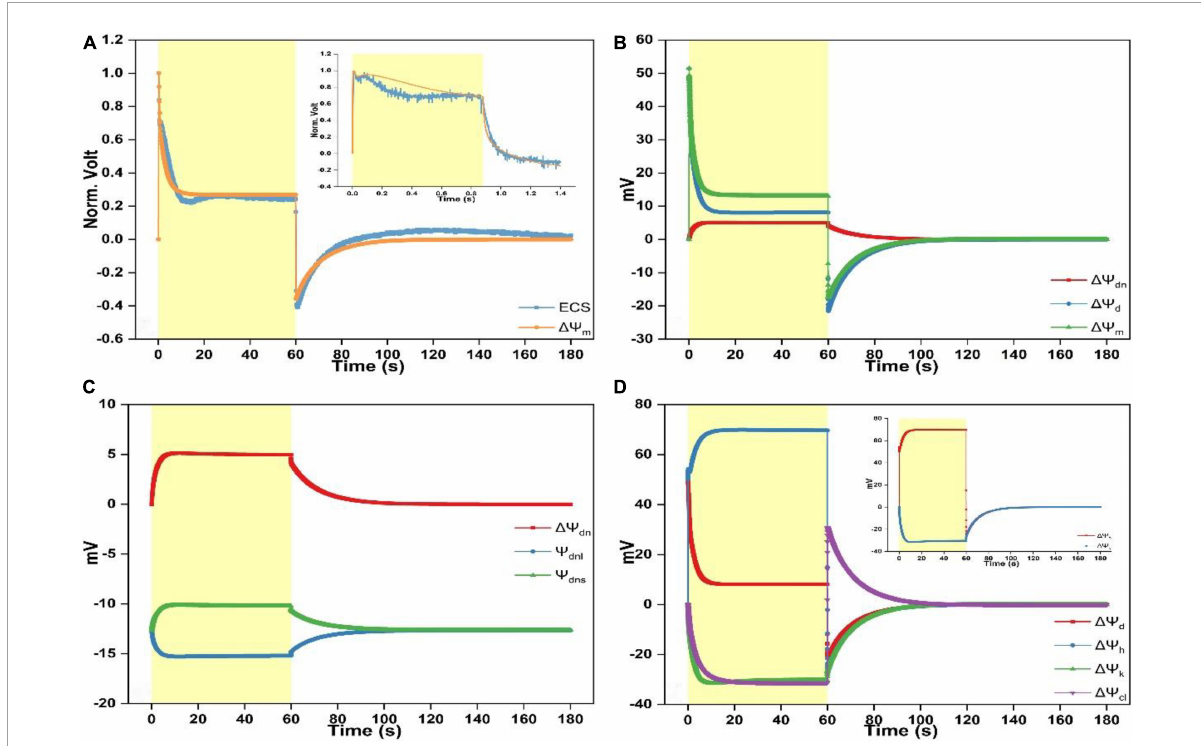
FIGURE1 Time courses of electrochromic shift (ECS) spectra and simulated electric potentials. (A) Comparison of the simulated response of (cid:49)(cid:57) m to the measured (cid:49) A515–560-nm signal upon continuous illumination for 60 s followed by the dark adaptation for another 120 s. The insert depicts the comparison of the measured (cid:49) A515–560-nm signal with the simulated response of (cid:49)(cid:57) m upon continuous illumination for ∼ 1 s followed by the dark treatment for ∼ 0.5 s. (B) Simulated responses of (cid:49)(cid:57) dn , (cid:49)(cid:57) d , and (cid:49)(cid:57) m upon continuous illumination for 60 s followed by the dark adaptation for another 120 s. (C) Simulated responses of (cid:57) dnl , (cid:57) dns , and (cid:49)(cid:57) dn upon continuous illumination for 60 s followed by the dark adaptation for another 120 s. (D) Simulated responses of (cid:49)(cid:57) d , (cid:49)(cid:57) h , (cid:49)(cid:57) k , and (cid:49)(cid:57) cl upon continuous illumination for 60 s followed by the dark adaptation for another 120 s. The insert depicts the simulated responses of (cid:49)(cid:57) h and (cid:49)(cid:57) k . Light intensity for continuous light (duration 1 or 60 s) was 1,024 µ mol photons m - 2 s − 1